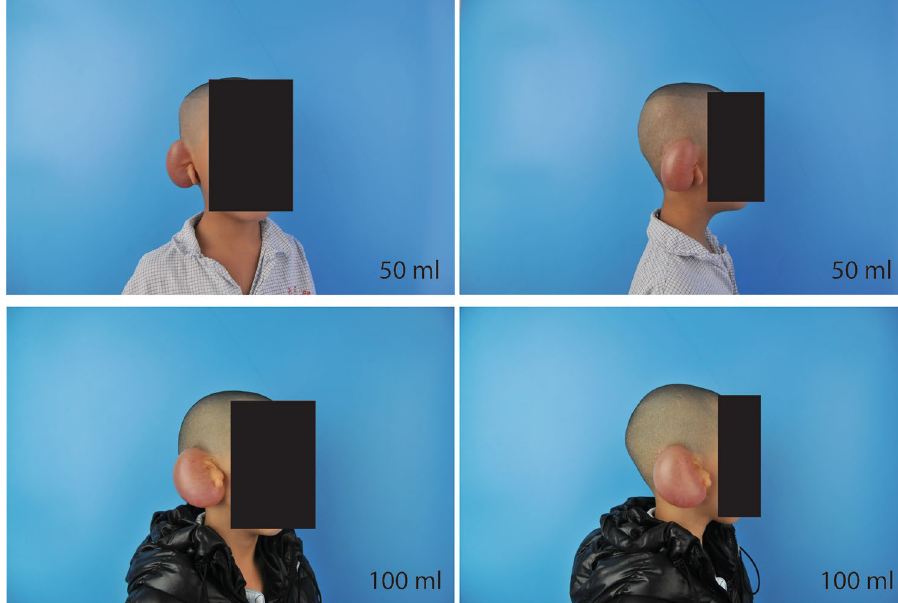
Figure 3. The specifications of the two expanders that are used in our clinical work. Both expanders can obtain satisfactory flaps, but there are no clear guidelines for their selection and